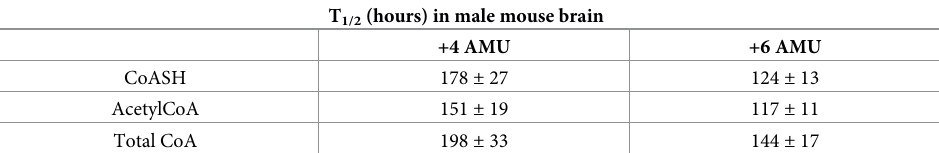
Table 6. Summary of half-life in mouse brain for free CoA (CoASH), acetylCoA and total CoA (+4 and +6 AMU) after striatal injection of +6 AMU